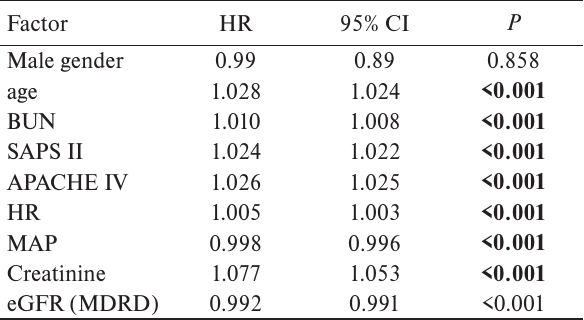
Table 3. Univariate analysis eICU patients.